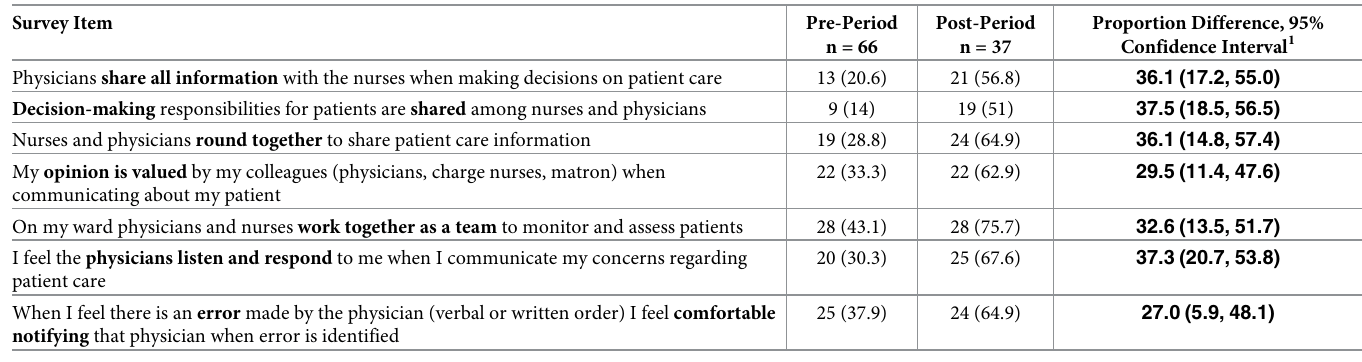
Table 2. Change in survey response, nurses.